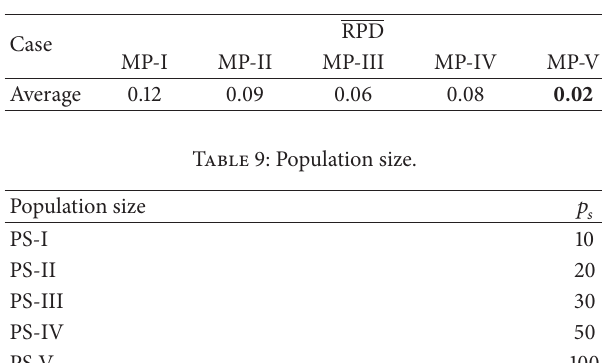
Table 8: Comparisons of different mutation types.